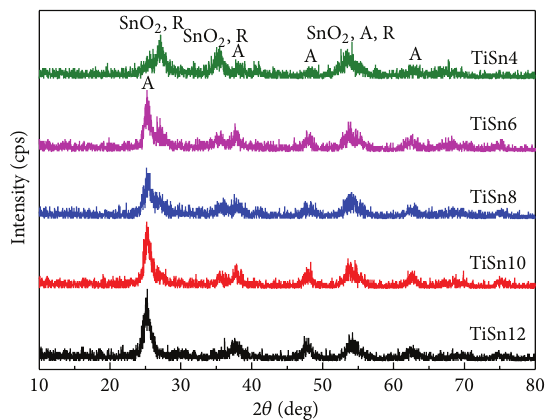
Figure 1: XRD patterns of the prepared samples TiSn4, TiSn6, TiSn8, TiSn10, and